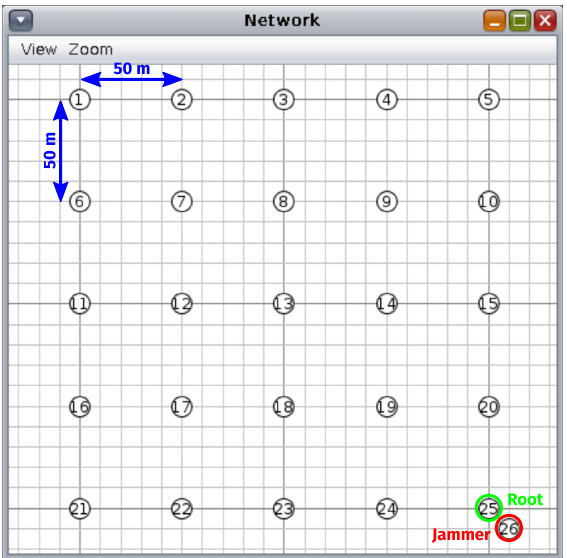
Figure 7. View of the simulated RPL network in the Cooja network window. Note that all simulated RPL nodes are arranged in an equidistant grid of 25 by 25 nodes. The RPL root is indicated in green, while the jammer (which is only active during half of the simulation runs) is indicated in